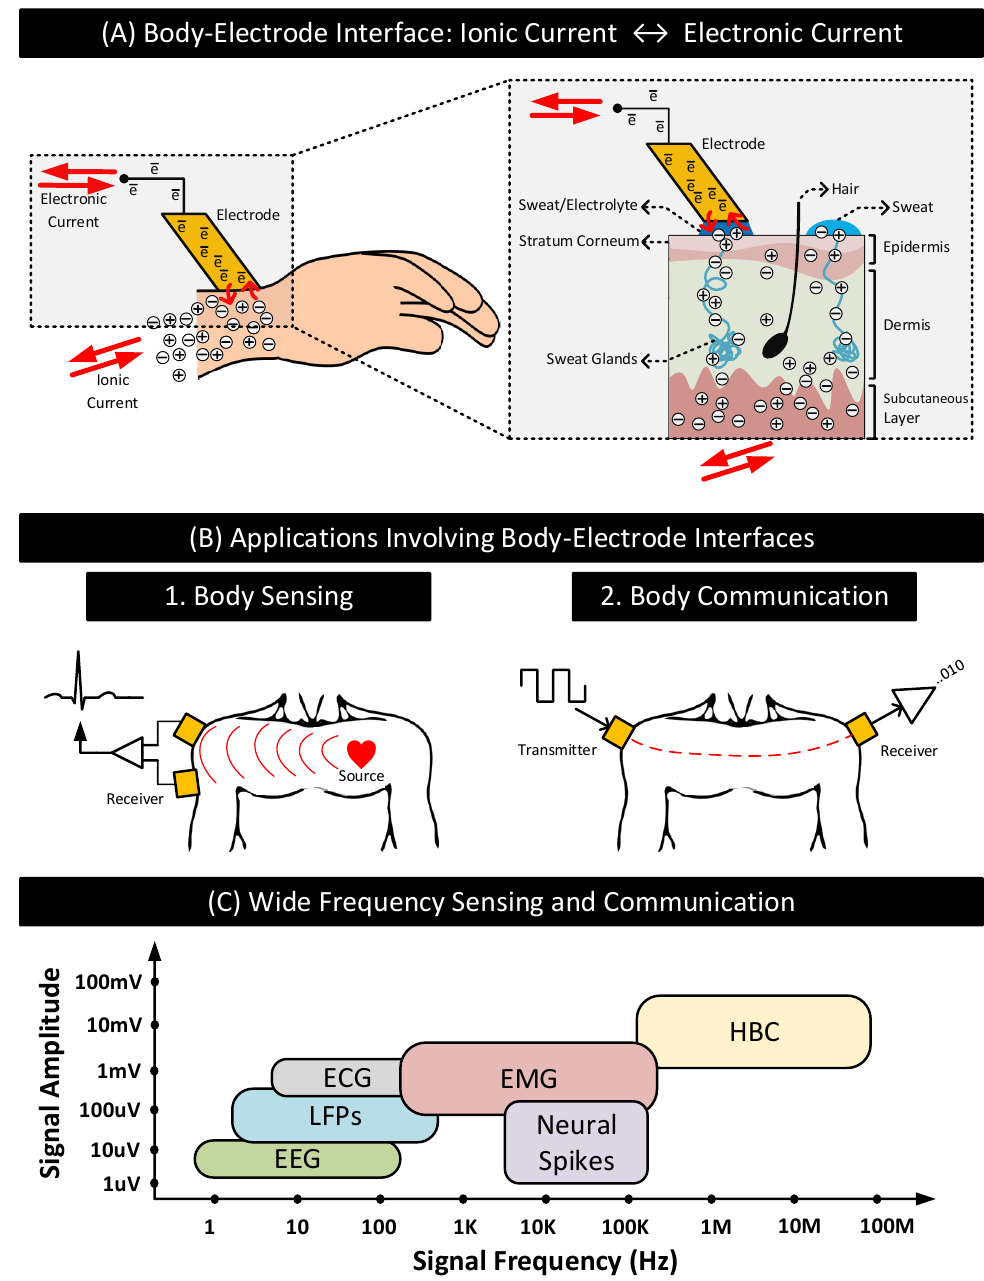
Figure 1. ( A ) A typical body–electrode interface: ionic current in the body is converted to electronic current and vice versa at the interface. ( B ) Differential sensing of signals from the body and commu- nication of data signals through the body using electrodes. ( C ) Approximate signal amplitudes and frequency ranges of biopotential and HBC